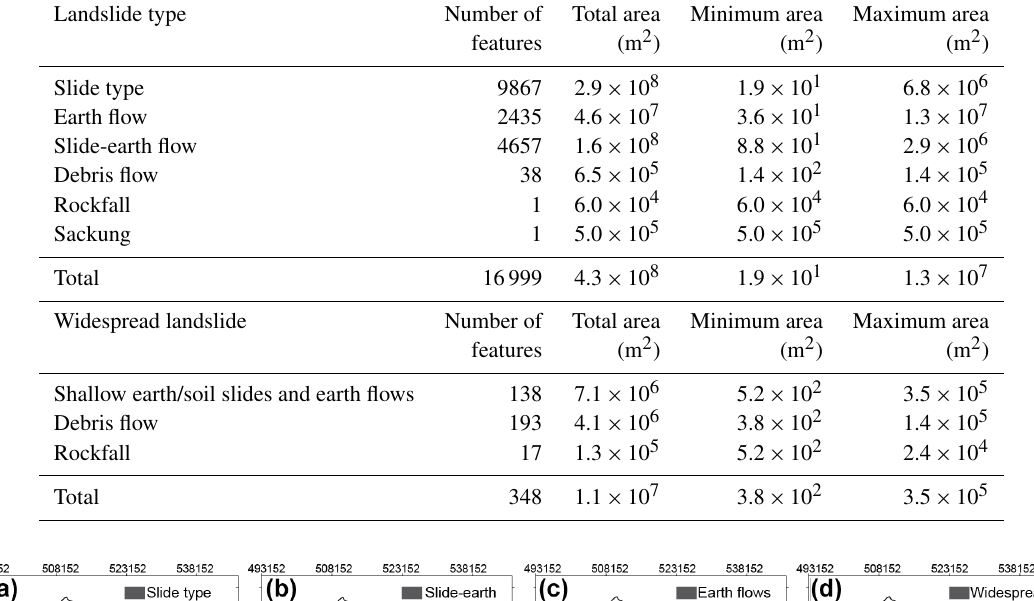
Table 2. Descriptive statistics of landslides by type.